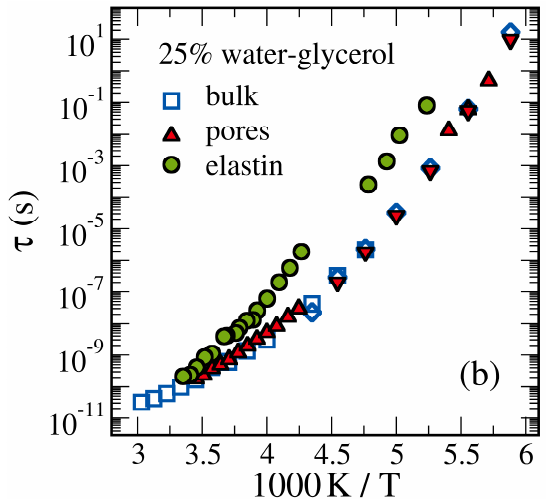
Figure 12. Temperature-dependent 2 H NMR correlation times of 25 wt % water-glycerol-d 5 mixture in the bulk liquid, in MCM-41 pores (diameter 2.8 nm), and in an elastin matrix (0.3 g solvent / g elastin ) [217]. The 2 H NMR data (squares, circles, and up triangles) selectively characterize the rotational motion of the deuterated glycerol compound. The BDS data (diamonds, down triangles) receive contributions from both water and glycerol reorientations.